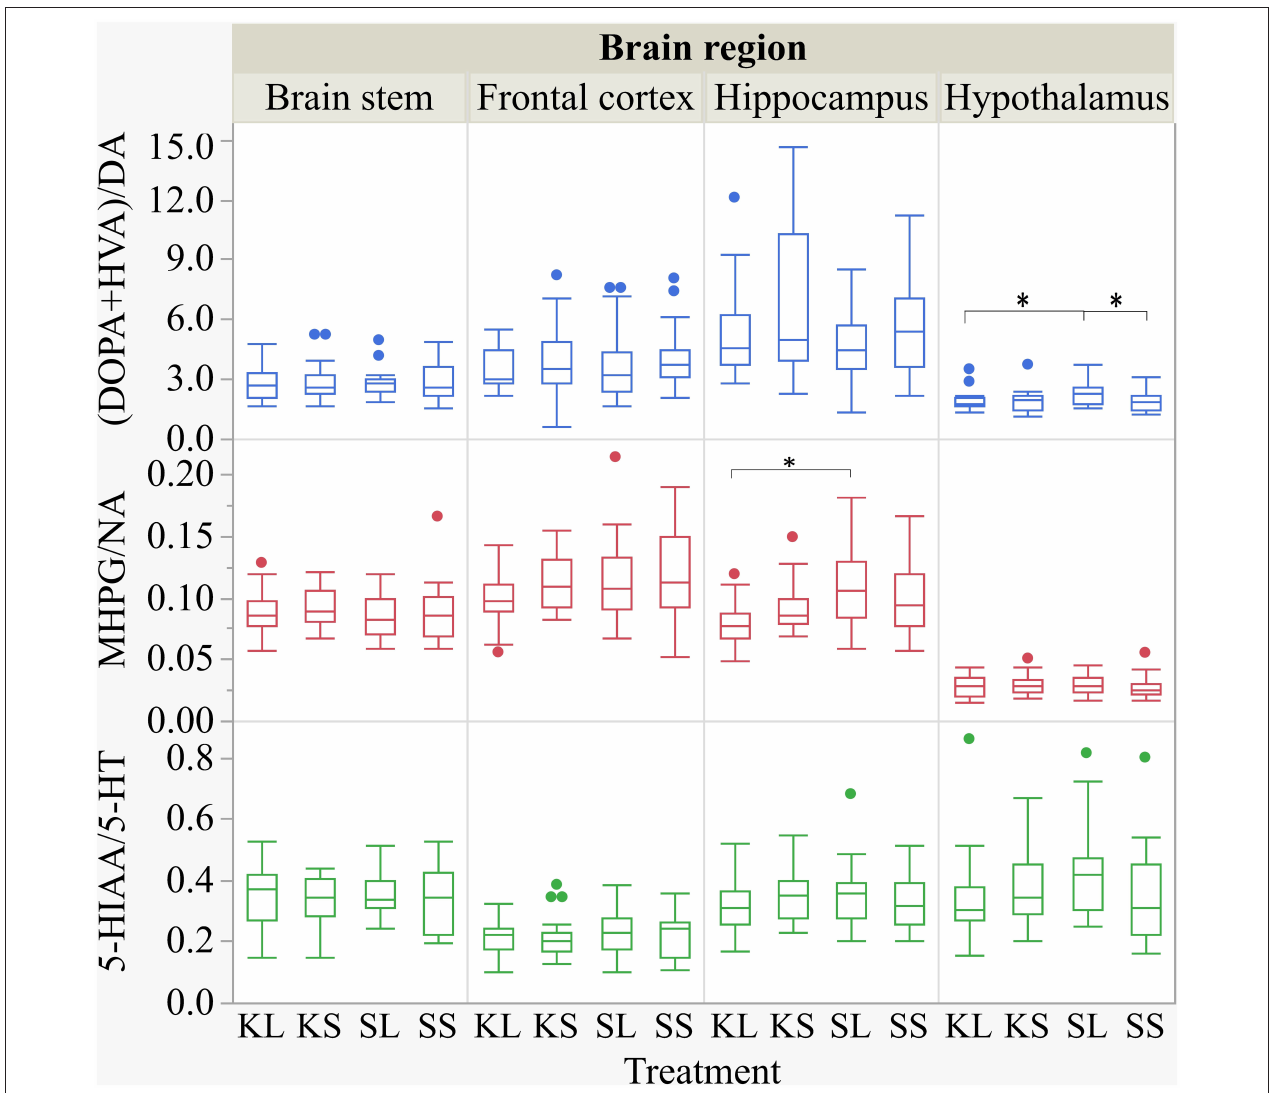
FIGURE 8 | Dopamine turnover, noradrenaline turnover, and serotonin turnover in the brain stem, frontal cortex, hippocampus, and hypothalamus of pigs at 72h after the injection with ketoprofen–lipopolysaccharide (LPS) (KL), ketoprofen–saline (KS), saline–LPS (SL), and saline–saline (SS). The turnover rates were calculated based on moles per milligram of the respective analyte. To improve the readability, seven outliers were removed from the figure (two KS, two SS, and two SL in the hippocampus and one KL in the frontal cortex). Round dots indicate outliers. Significant differences of planned comparisons between treatments ( p < 0.05) are marked with an